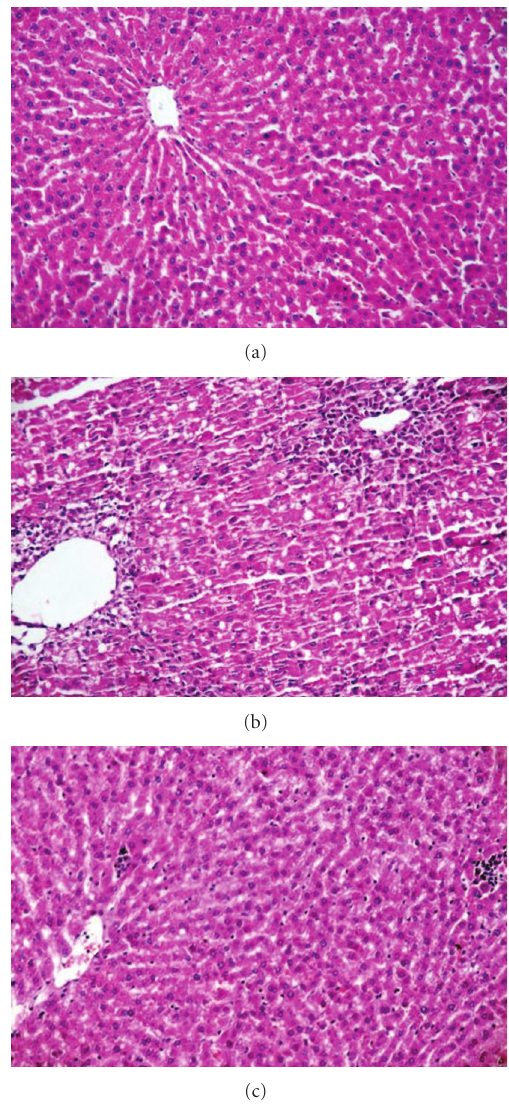
Figure 1: Histopathological findings in groups. (a) Normal liver histology from liver section rat fed on standart diet (H&E × 200). (b) Macro- and microvesicular steatosis and ballooning degeneration around the central vein from liver section rat fed on HFD (Hematoxylen-Eosin (H&E × 200). (c) The marked decreased steatosis and inflammation from liver section rat fed on HFD + lycopene (H&E ×